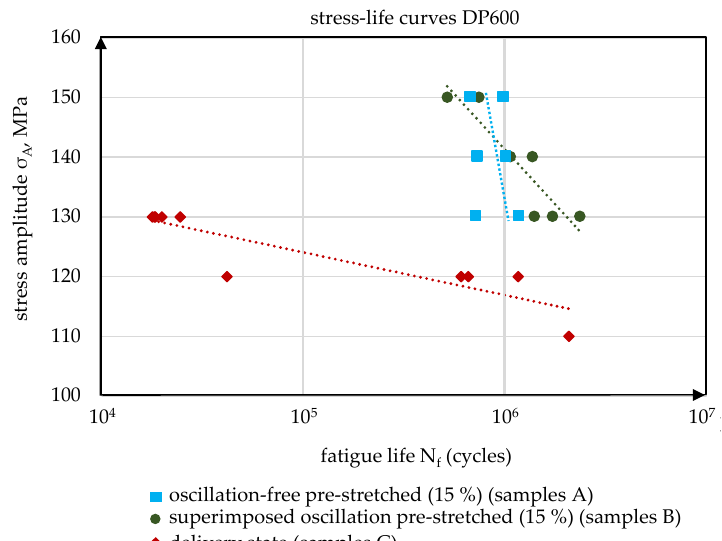
Figure 2. Stress-life curves for flat-tensile test specimens made out of DC04.